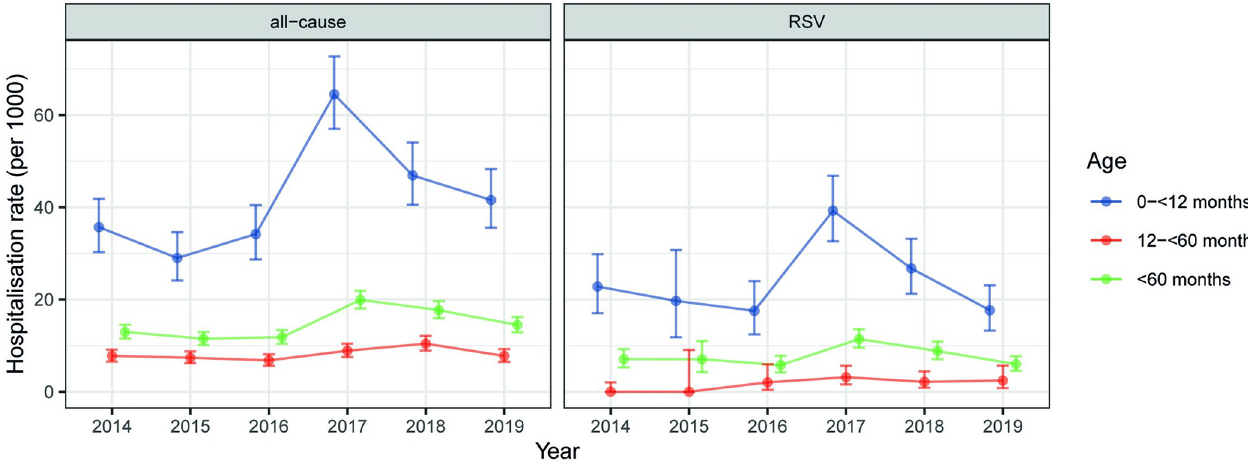
Fig 1. Year-on-year variations on annual hospitalisation rates of all-cause and RSV-associated ALRI in children under five years of age. RSV = respiratory syncytial virus; ALRI = acute lower respiratory infection.